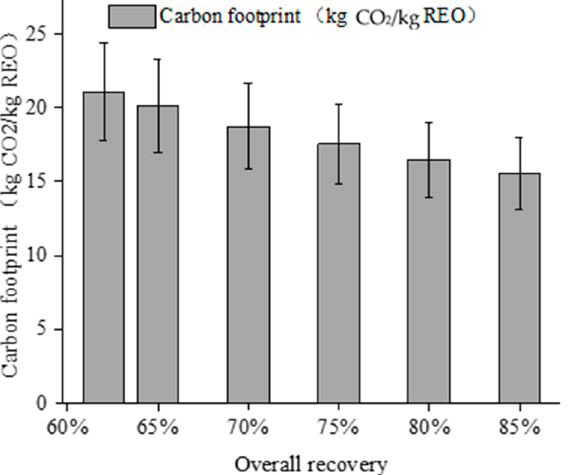
Figure 5. Effect of product recovery rate on carbon footprint of ionic rare earth development.